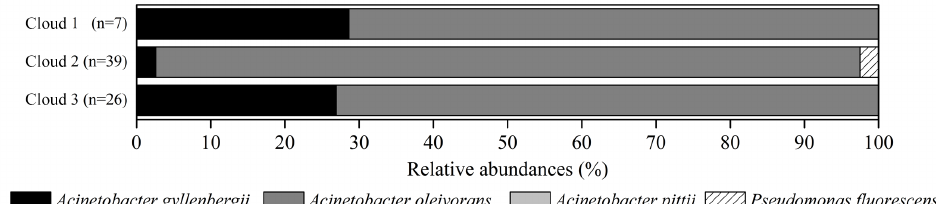
Figure 3. Relative abundance of the putative taxonomic affiliation of the microorganisms involved in phenol degradation. For the five databases, microorganisms associated with a matching sequence with cloud transcripts are plotted here; the absolute total number of hits for each sample is indicated ( n